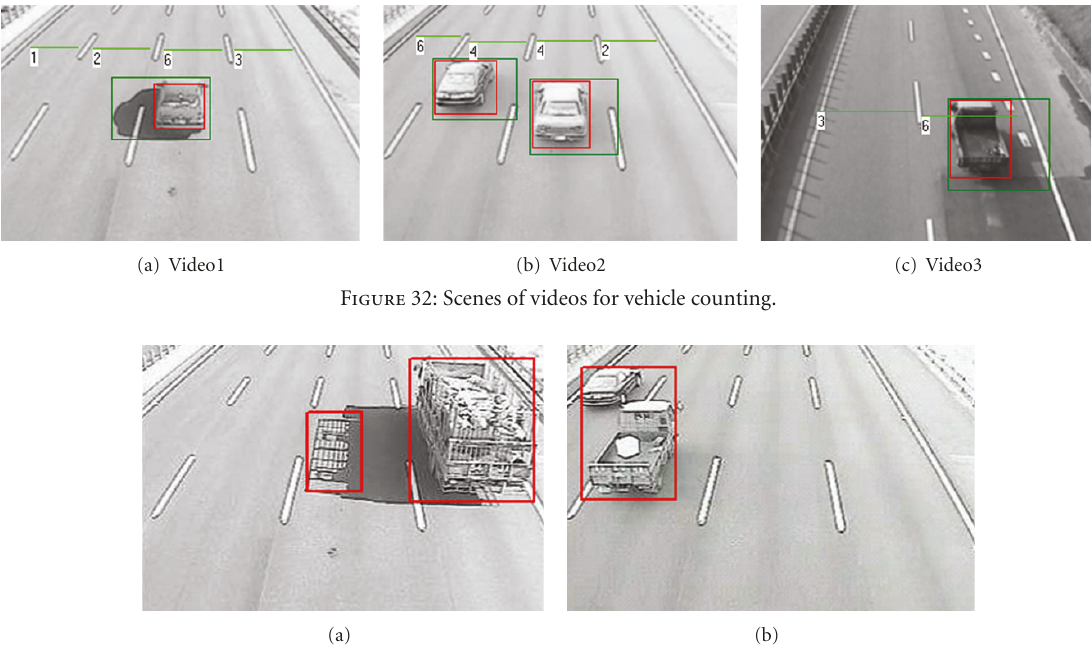
Figure 33: Some failed examples of image frames for (a) the much-texture case and (b) the special occlusion